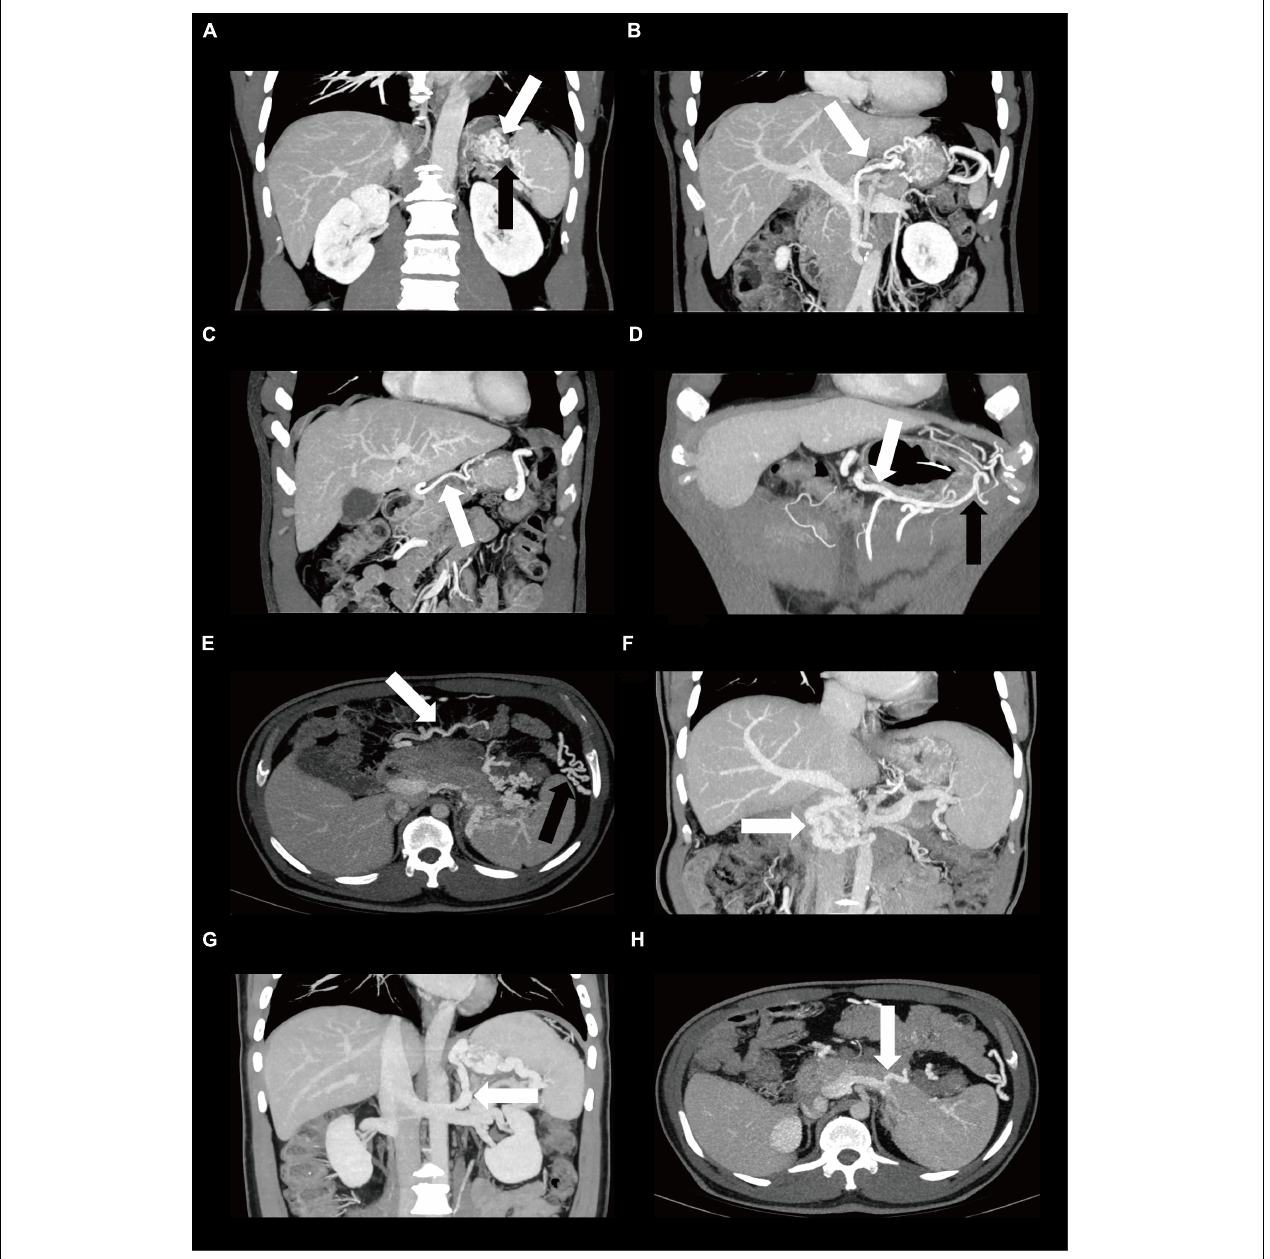
FIGURE 1 | The Contrast-enhanced CT images of varices in patients diagnosed as SPH. One of the main collateral pathway is through enlarged short gastric varices ( A , black arrow) and gastric fundus varices ( A , white arrow) via gastric coronary varices ( B , white arrow) or rarely via right gastric varices ( C , white arrow) drained into the portal vein. Another collateral pathway is through left gastroepiploic varices ( D , black arrow) via right gastroepiploic varices ( D , white arrow) drained into the superior mesenteric vein. Other abnormal varices due to portal hypertension include middle colonic vein ( E , white arrow), omentum branch of the gastroepiploic vein ( E , black arrow), pancreaticoduodenal vein ( F , white arrow), left adrenal vein ( G , white arrow), and dorsal pancreatic vein ( H , white arrow). CT, computed tomography, SPH, sinistral portal hypertension.